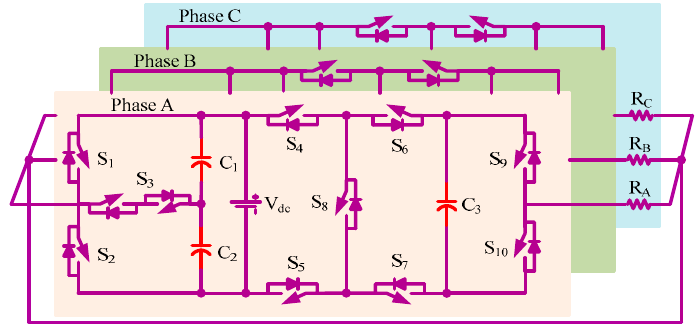
Figure 2. Three-phase nine-level switched capacitor MLI.